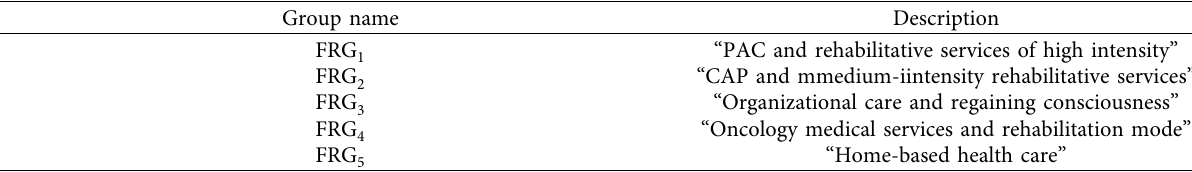
Table 4: Function-related groups.